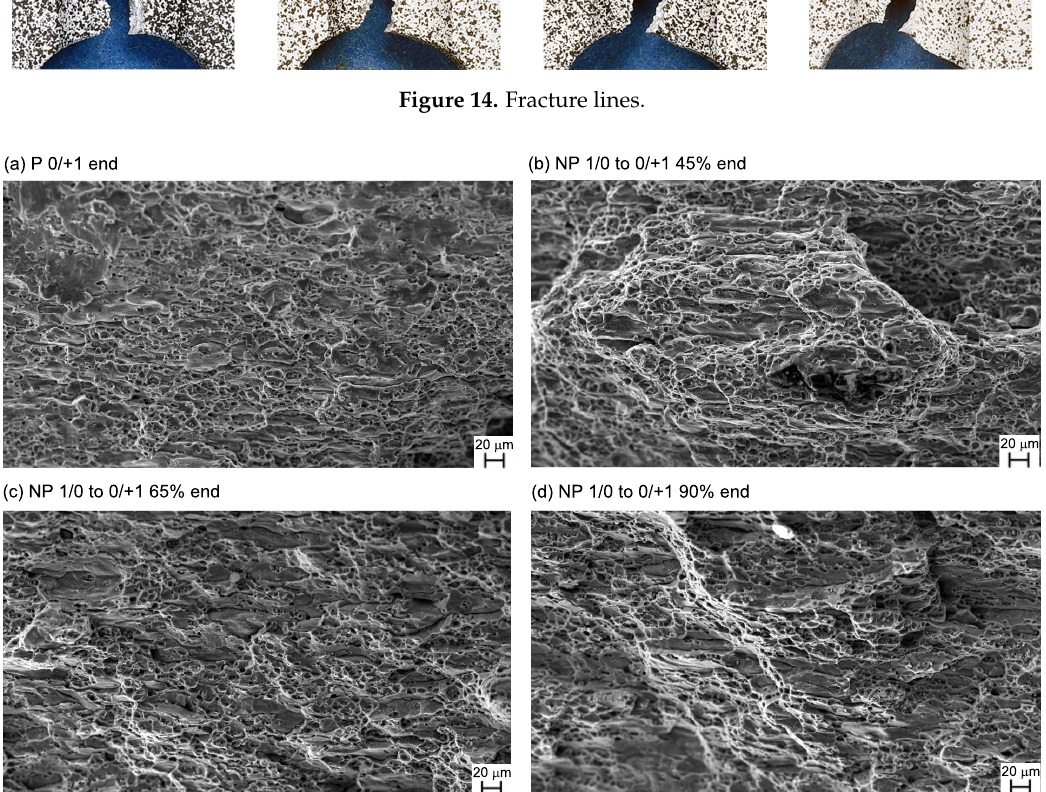
Figure 15. SEM pictures of the fracture